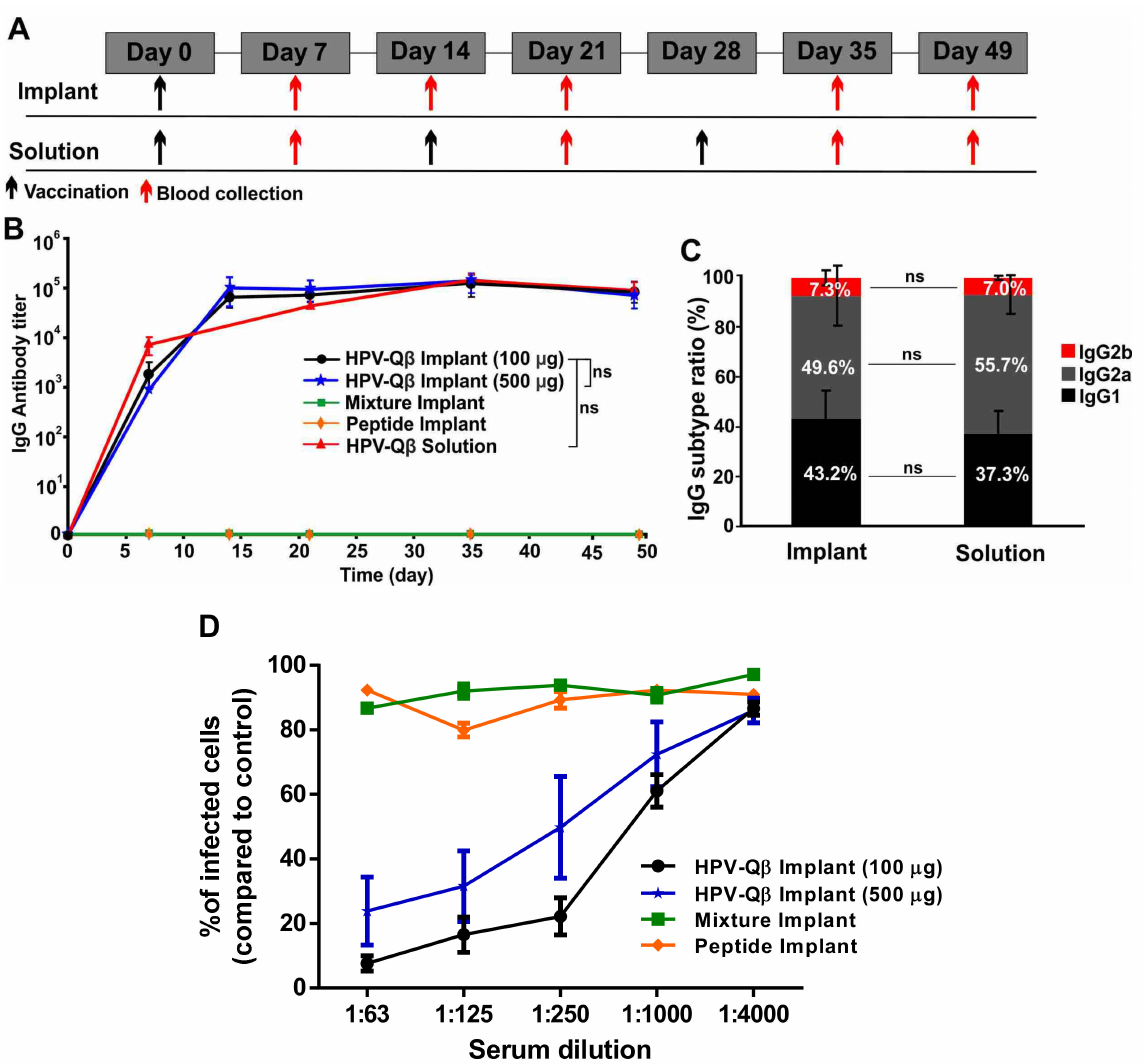
Figure 5. Single-dose vaccination using PLGA implants loaded with HPV-Q β . ( A ) Vaccination and bleeding schedule for mice with subcutaneous PLGA implants or equivalent HPV-Q β injections. ( B ) Serum titers of HPV-specific IgG for mice vaccinated with three subcutaneous injections of 30 µ g HPV-Q β or a single-dose PLGA implant loaded with 100 µ g HPV-Q β , 500 µ g HPV-Q β , a mixture of 100 µ g Q β and 20 µ g HPV peptide, or 20 µ g HPV peptide alone (Data are means ± s.d. for n = 6 mice per group). Statistical significance was determined by unpaired two-tailed student’s t -test: ns, not significant with p > 0.05. ( C ) HPV-specific IgG subtype ratio for mice vaccinated with a single-dose PLGA implant containing 100 µ g HPV-Q β , or three subcutaneous doses of 35 µ g HPV-Q β . Blood was collected on day 35 (Data are means ± s.d. for n = 6 mice per group). ( D ) Serum (day 35) from three mice immunized with various vaccine formulations tested in duplicate for neutralization against HPV16 pseudovirus at ID 60 (pseudovirus infectious dose that infects 60–70% of control cells). Infected cells (expressing GFP) were identified by flow cytometry (data are means ± standard errors based on the relative percentage of infected cells in wells exposed to serum compared to non-exposed